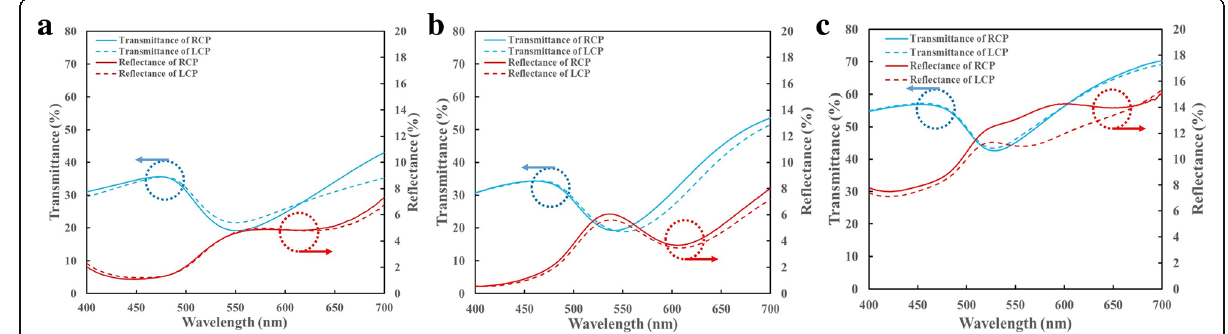
Fig. 4 Right-handed and left-handed circular polarized transmittance and reflectance spectra of sample 1 ( a ), sample 2 ( b ), and sample 3 ( c